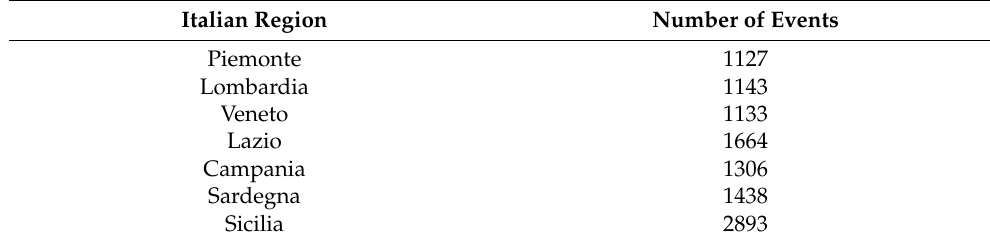
Table 3. Number Of Events for Each Italian Region.